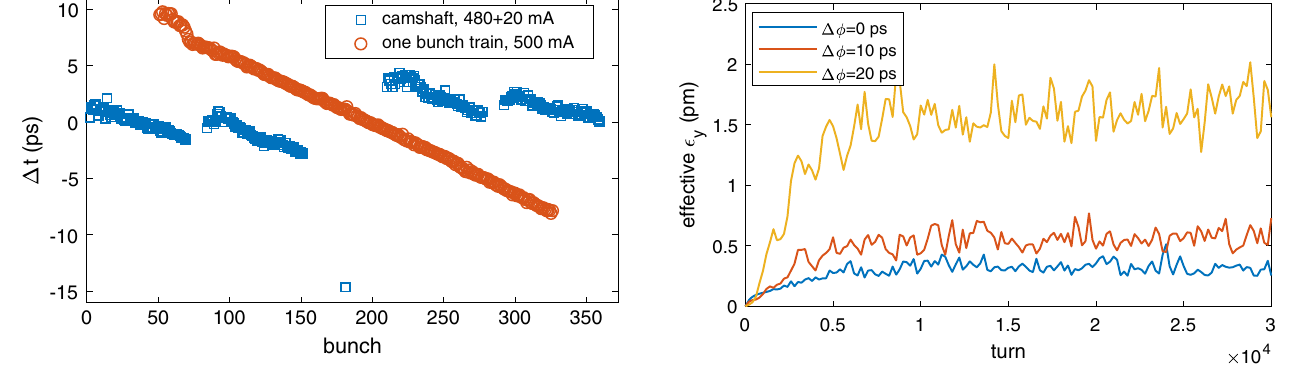
FIG. 9. Measured bunch arrival time distribution over the bunch train for two fill patterns in SPEAR3 with 500 mA total current and about 280 bunches.